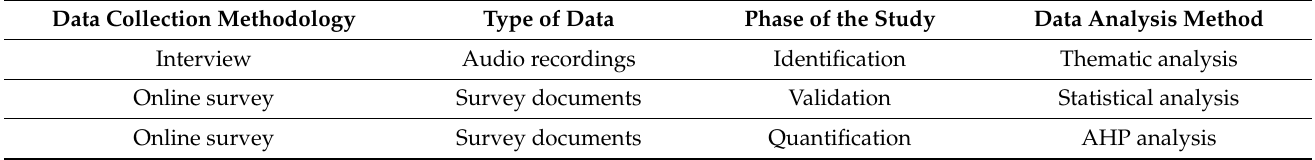
Table 1. Summary of data collection methods and analysis.